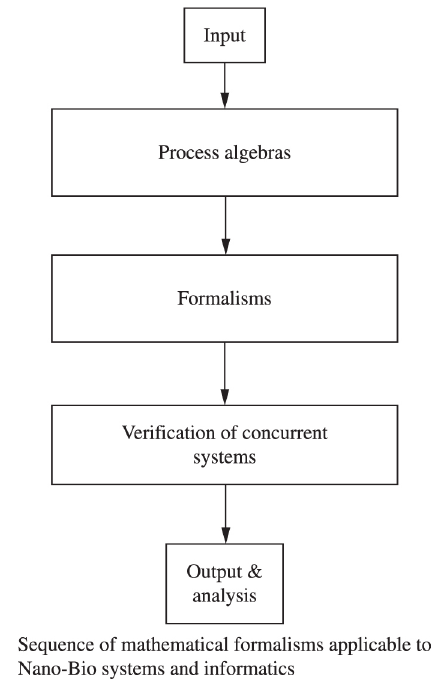
Figure 4. Mathematical Formalisms for applied informatics.